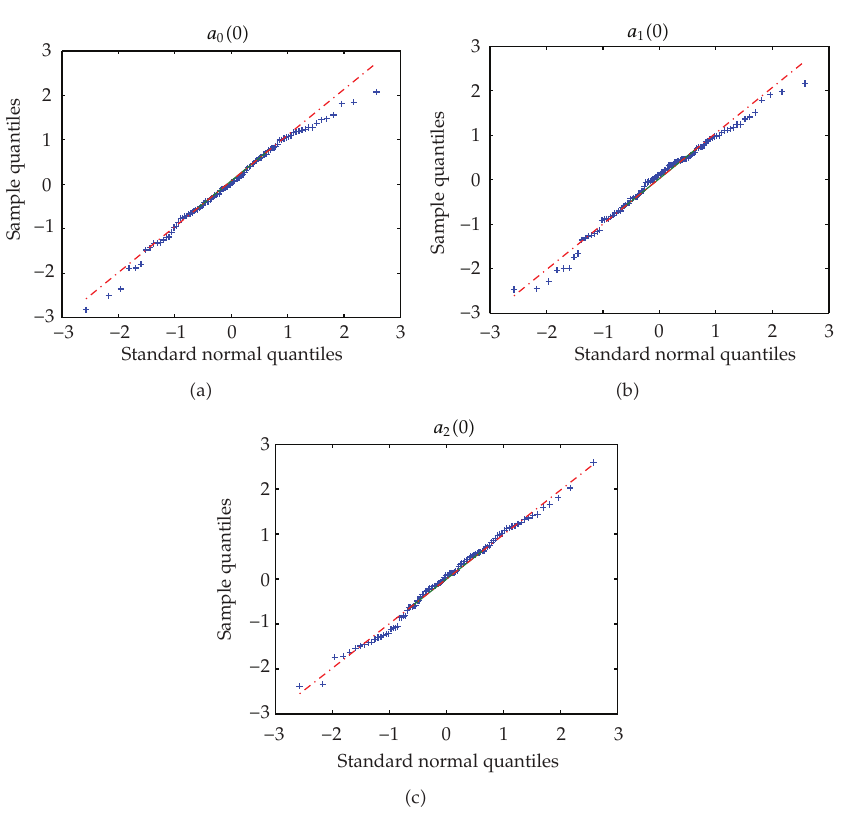
Figure 1: Normal QQ-plot for (cid:8) a 0 (cid:3) 0 (cid:4) , (cid:8) a 1 (cid:3) 0 (cid:4) and (cid:8) a 2 (cid:3) 0 (cid:4) (cid:3) n (cid:5) 100 (cid:4)